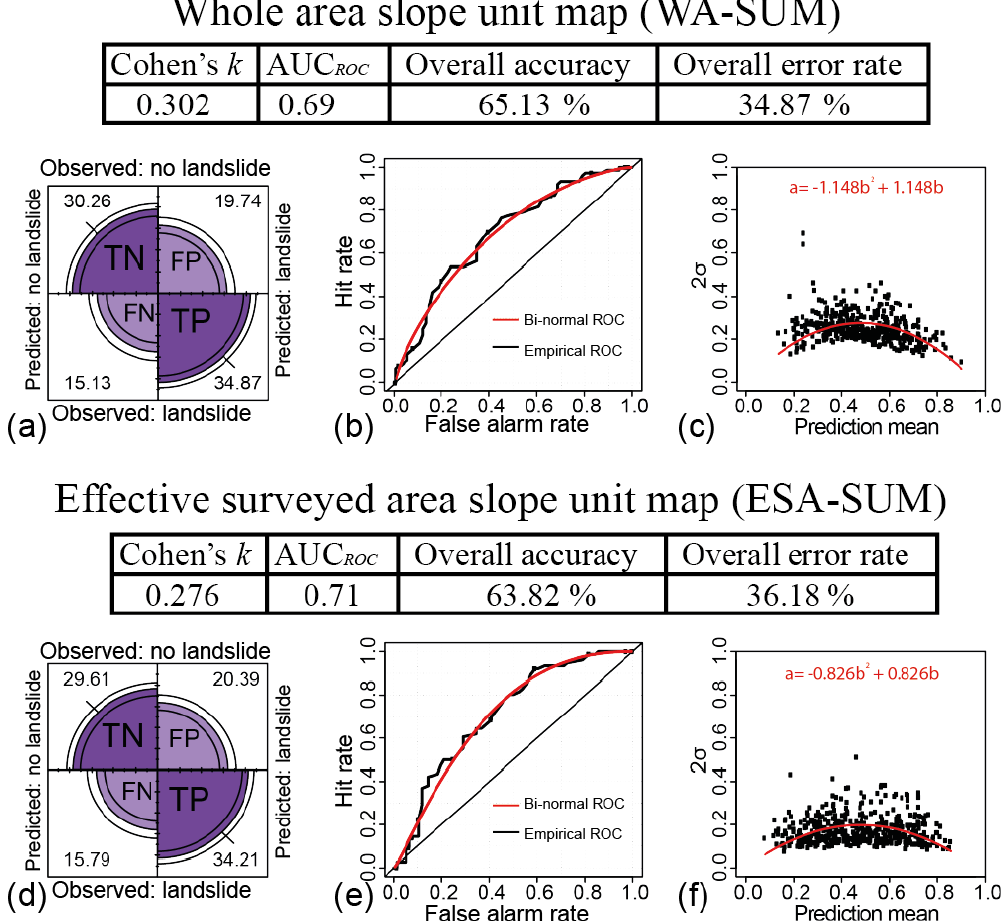
Figure 4. SU-based LR models prediction performance results: summary tables of the Cohen’s kappa index, area under the ROC curve (AUC), overall accuracy ((TP + TN) / (TP + TN + FP + FN)) and overall error rate ((FP + FN) / (TP + TN + FP + FN)). (a, d) Four-fold or contin- gency plots; (b, e) ROC curves; (c, f) classification error plots and the quadratic regression fit curves (red